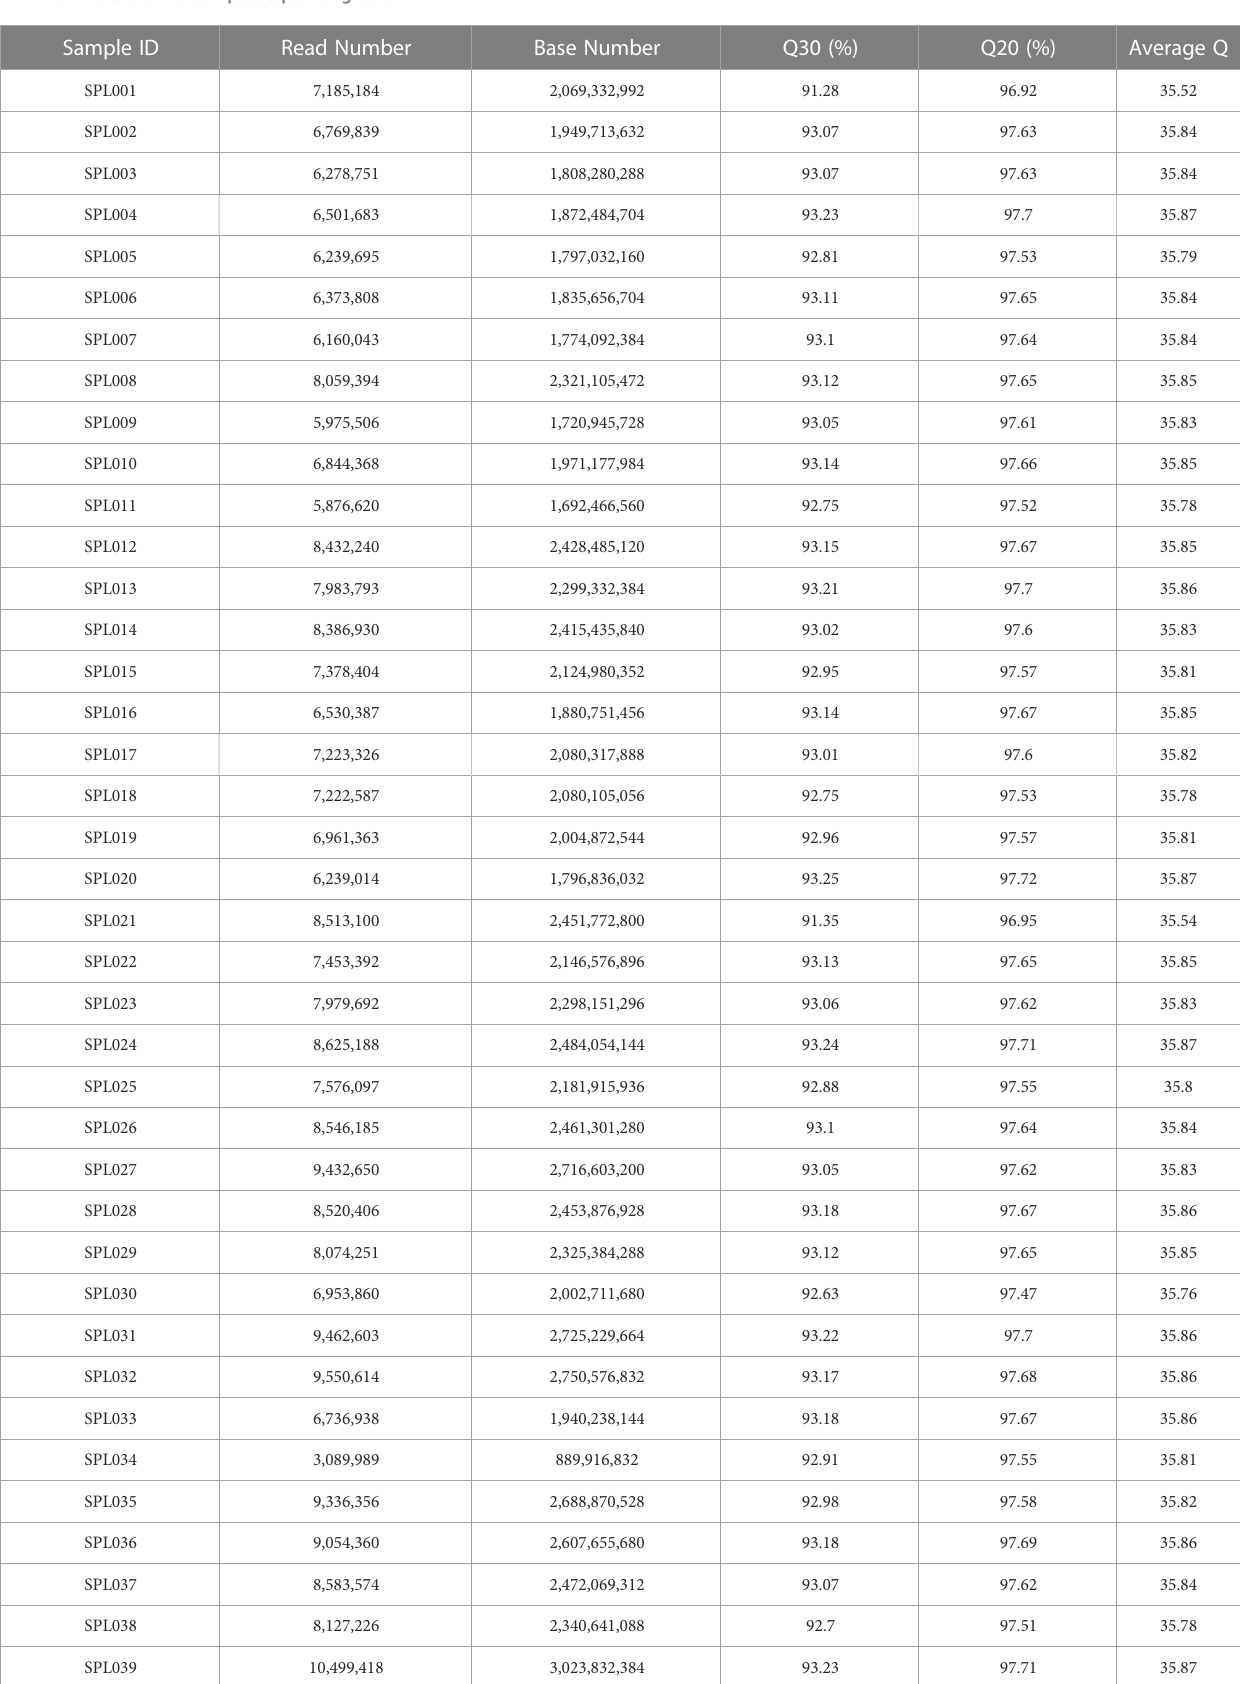
TABLE 3 Evaluation of sample sequencing